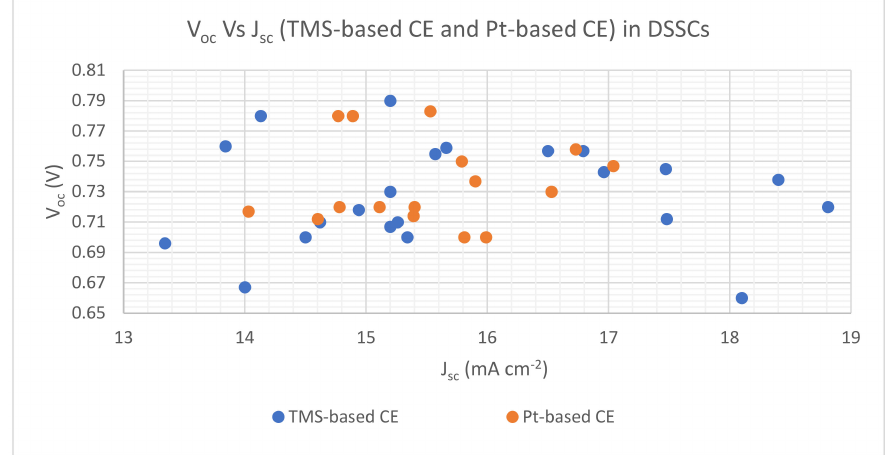
Figure 9. The V oc Vs J sc for TMS-based CE and Pt-based CE in